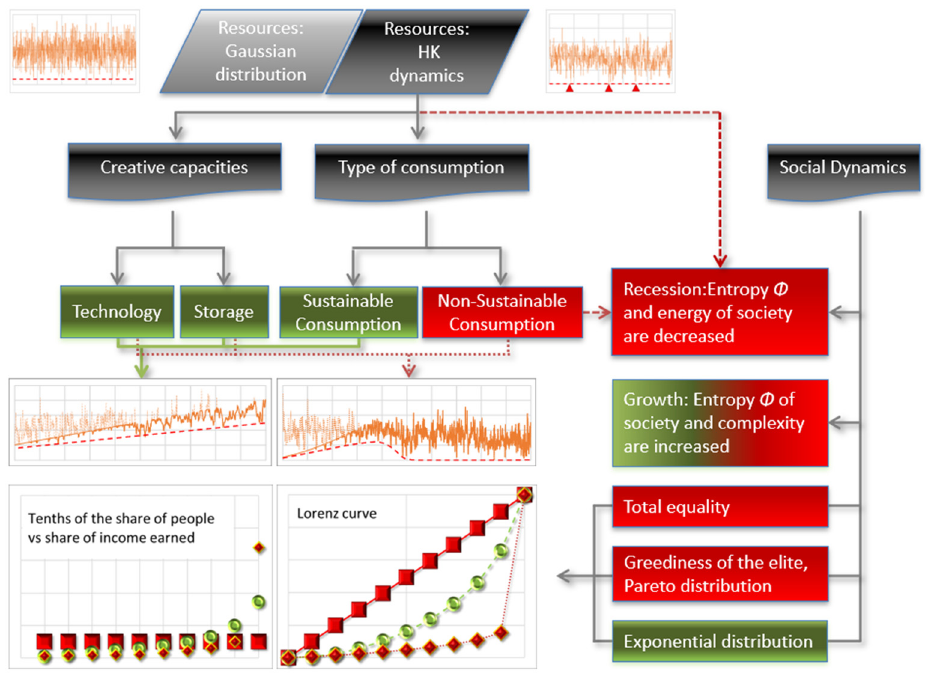
Figure 9. Summary of methodology. Green color shows aspects of a flourishing society; red color shows aspects with a dynamic of collapse.